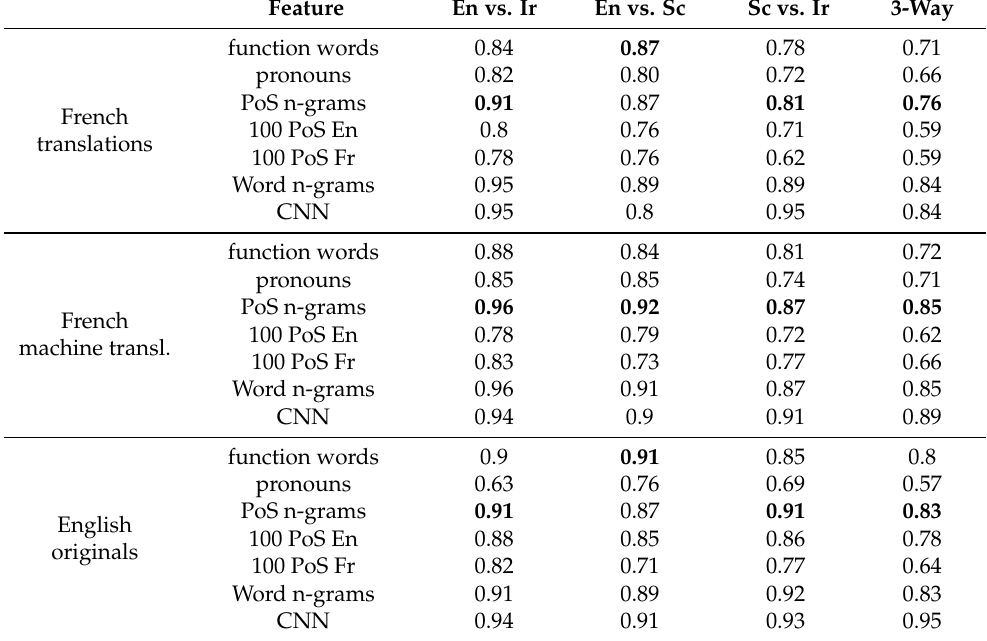
Table 2. Average F 1 scores for distinguishing dialectal varieties and their translations into French. Values in bold indicate the best accuracy obtained using topic-independent features. The feature set 100 PoS En are the most representative n-grams for classifying original English documents and simi- larly 100 PoS Fr , for the human-translated French documents. Word n-grams (limited to a maximum of 300 most frequent) and convolutional neural networks (CNN) are covering content words and are biased by topic, therefore we do not highlight the classification scores of the two methods.